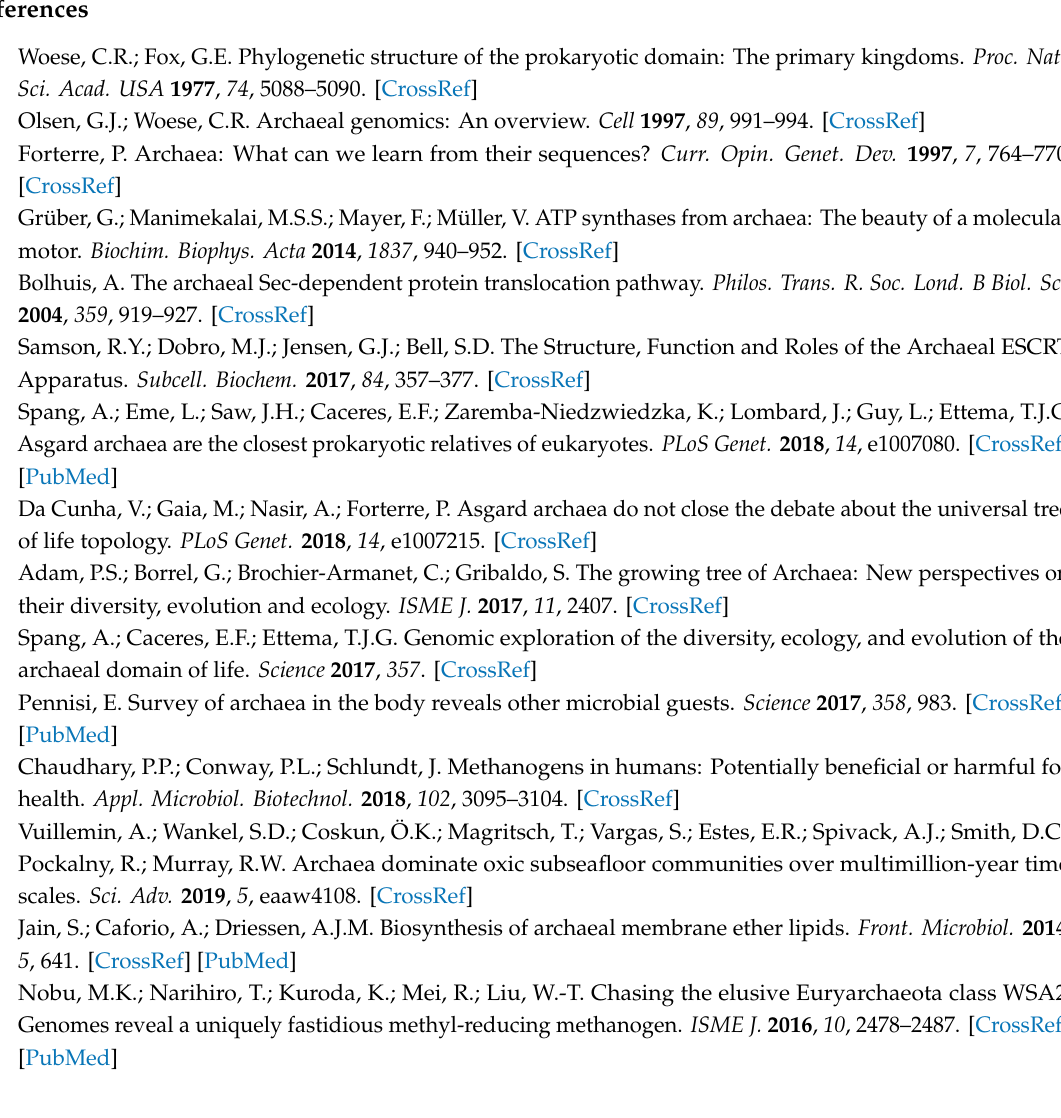
Figure S1: Experimental evidence for G4 formation with Hadesarchaea sequences at high temperature; Table S1: The accession codes and phylogenetic classification of all archaeal genomic DNA sequences, Table S2: Overall results of PQS frequencies found in each analyzed genomic sequence (all (A), superphylum (B) or phylum (C)) together with GC content, sequence length and other parameters, Table S3: Feature counts, Table S4: PQS characteristics used for the dendrogram shown in Figure 6, Table S5: Statistical evaluation, Table S6: BLASTp search for RecQ and NIQI in Archaea, Table S7: FIMO search for putative quadruplex binding motif, Table S8: The most similar protein of RecQ (E. coli) in Hadesarchaea